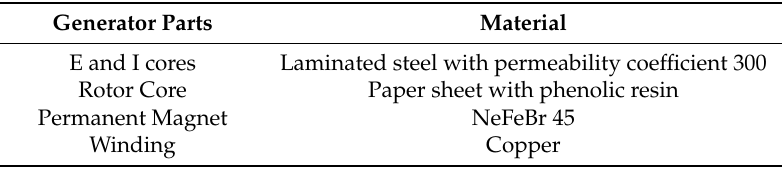
Table 5. Properties for material of the TFPMDEIG.